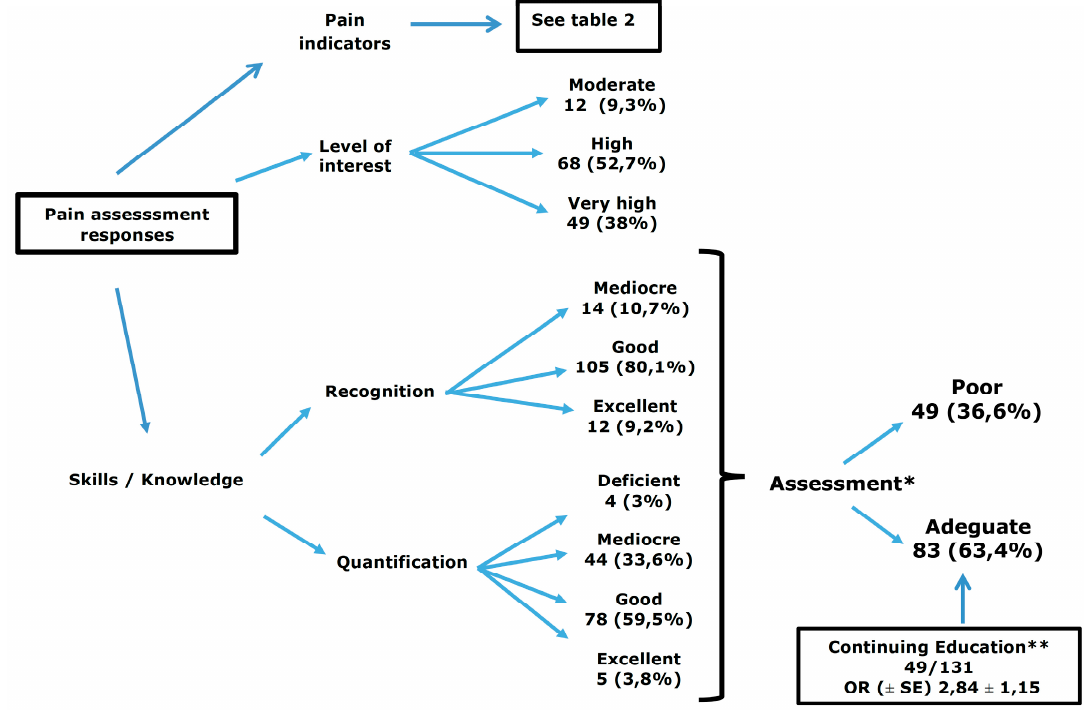
Figure 1. Pain assessment responses. * Pain assessment was arbitrarily deemed adequate when both “recognition” and “quantification” were excellent or good, and inadequate if one of these abilities was deficient, poor or mediocre. ** See section on results for further associations between pain assessment and different variables. Table 2. Ranking of pain indicators considered most useful in dogs and cats by 131 veterinarians in the city of Medellin,